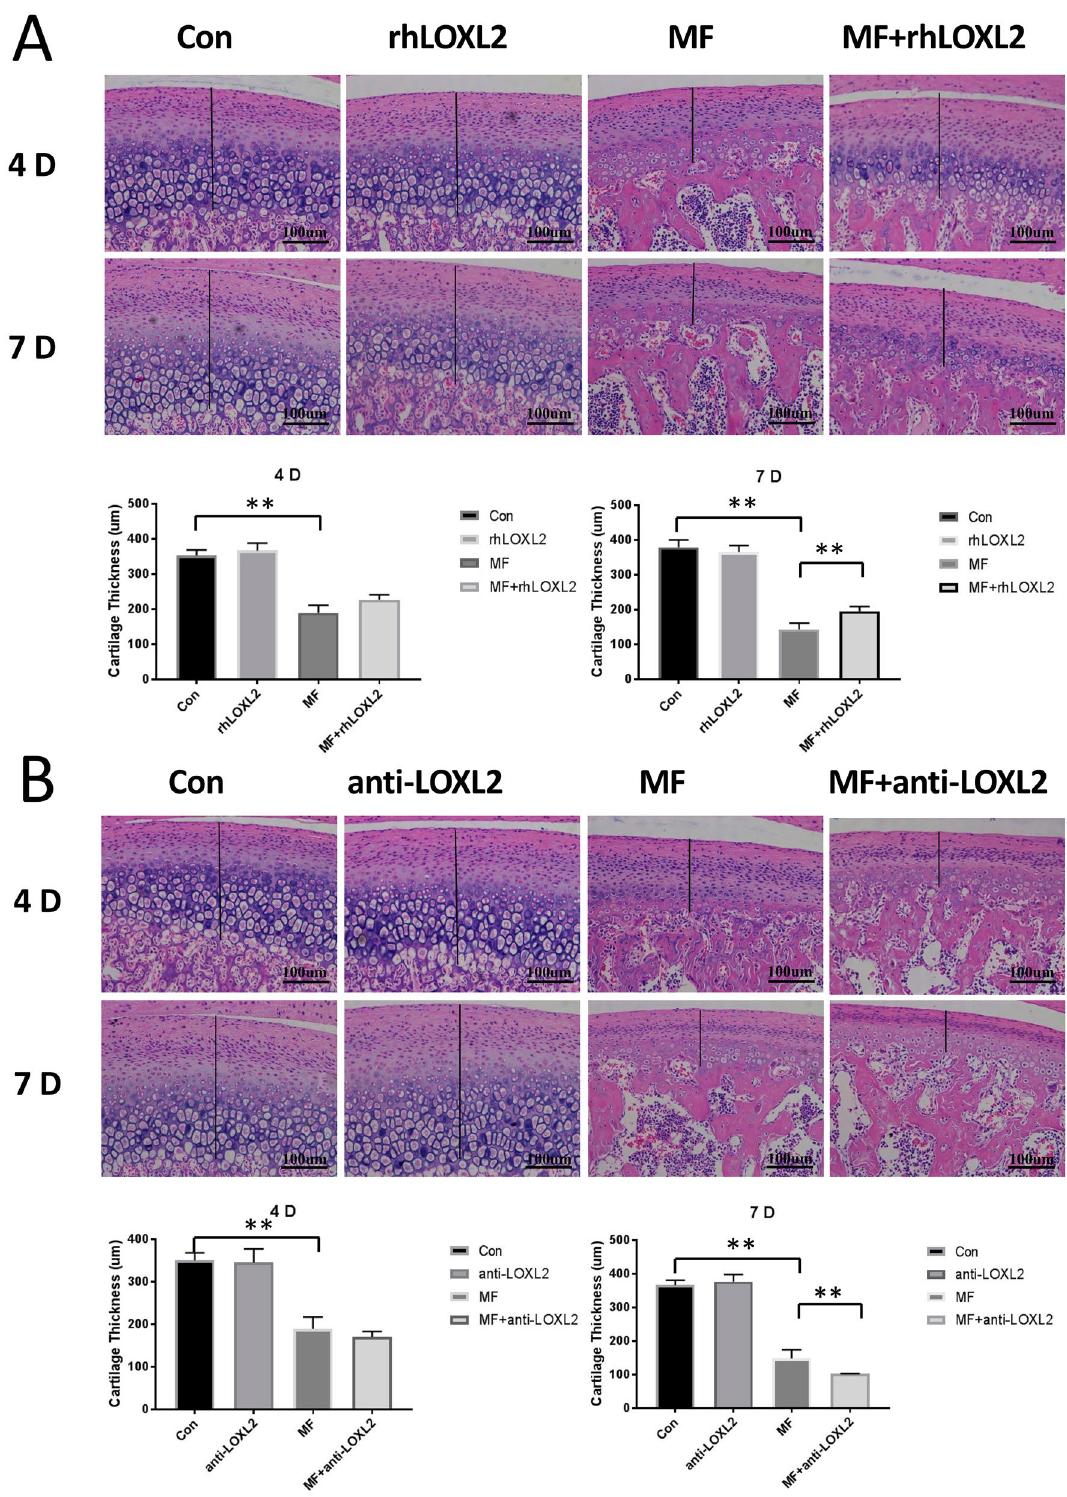
Figure 2. LOXL2 alleviated mechanical force-mediated cartilage thinning. HE-stained cartilage sections were treated as indicated (n = 12). ( A ) Cartilage thinning in MF groups was recovered by rhLOXL2, ( B ) while worsened by anti-LOXL2. The scale bar indicates 100 μm. Cartilage thickness is indicated by a black bar. Quantification of cartilage thickness was listed below the HE-stained images (n = 12). *P < 0.05, **P <